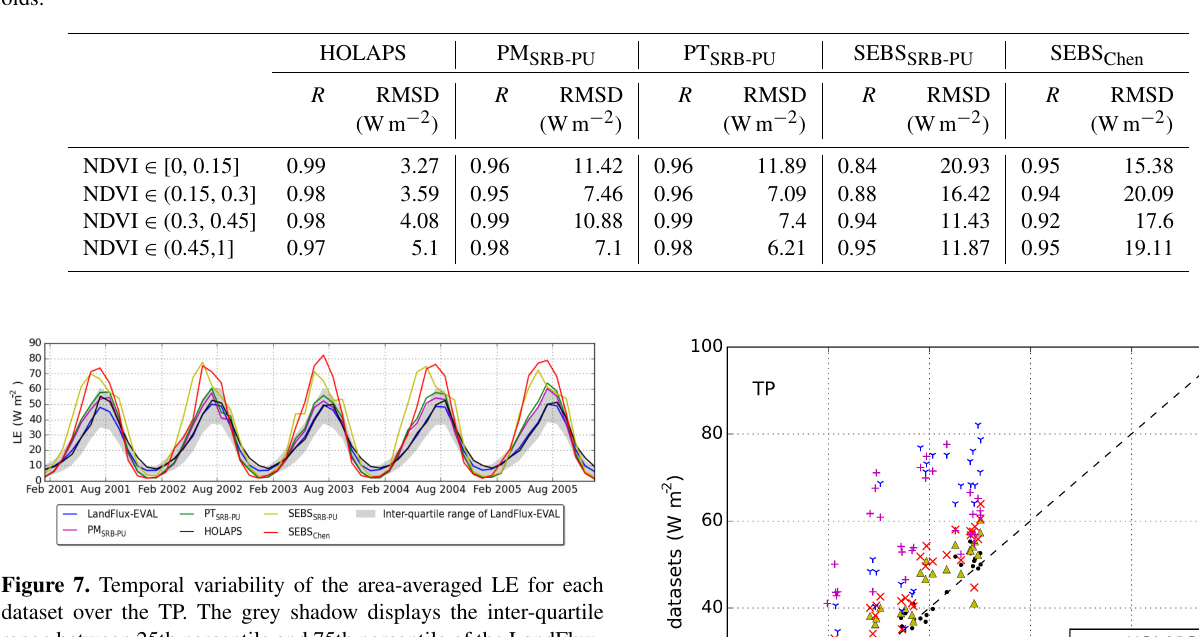
Tibetan Plateau Table 4. Statistics of the LE comparisons between the LandFlux-EVAL benchmark product and other products over different NDVI thresh- olds.